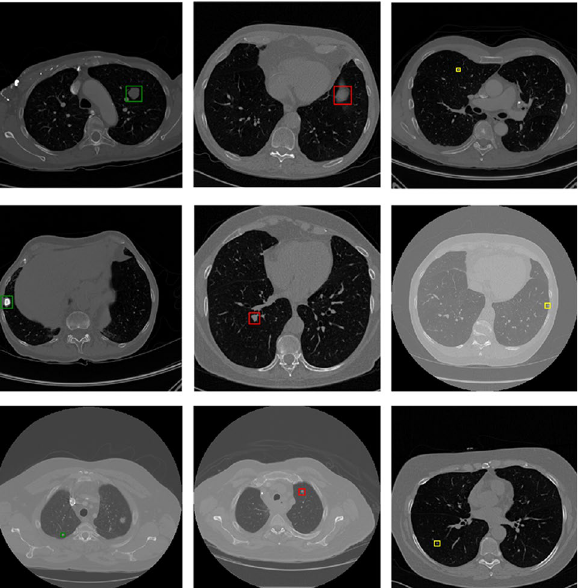
Figure 13. Detection results of true positive nodules, false positive nodules and false negative